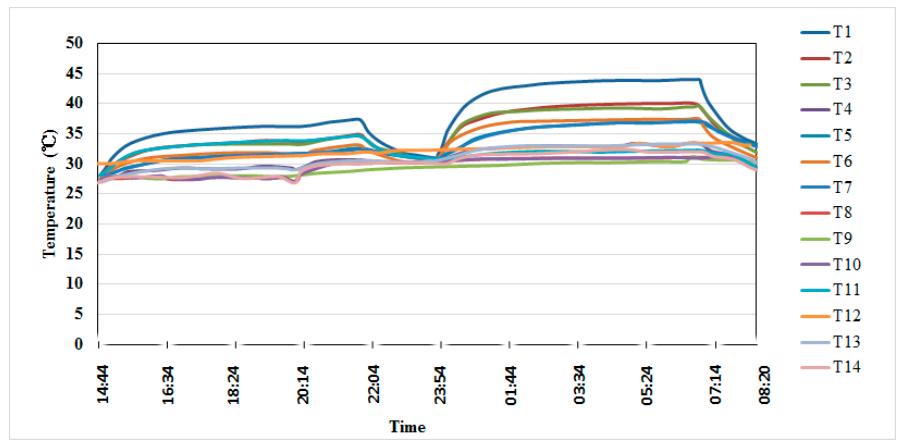
Figure 5. Initial temperature rises measured at 14 sensors.